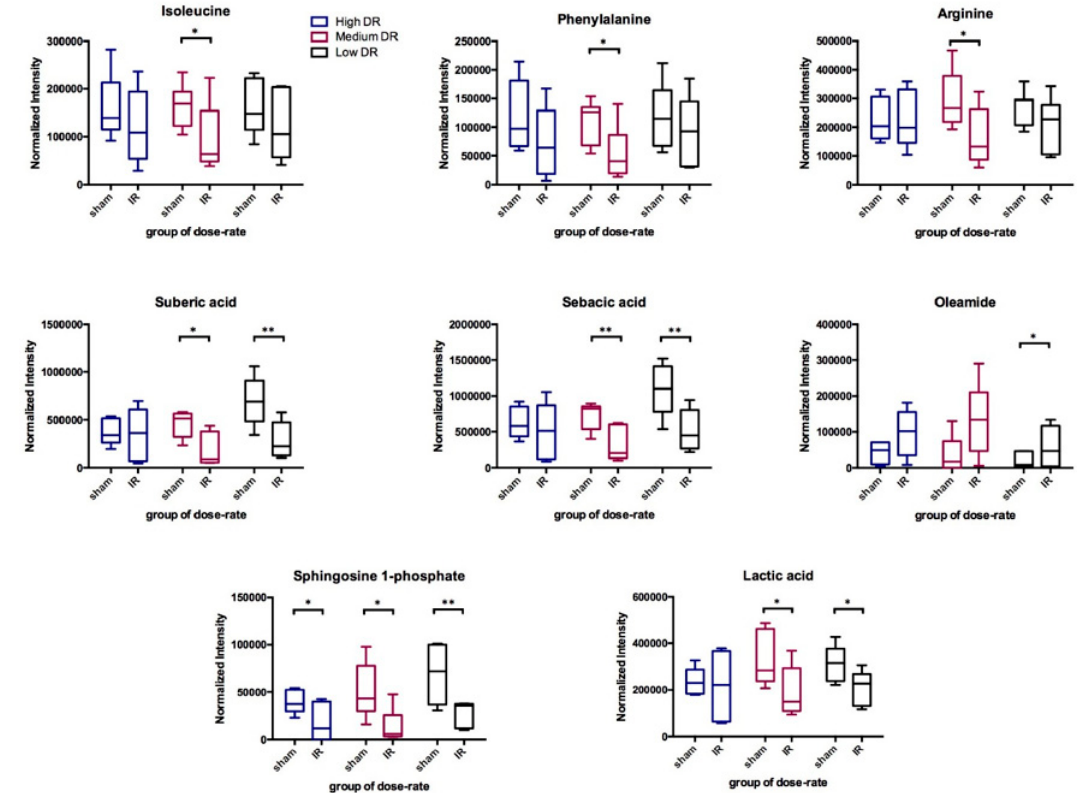
Figure 3. Changes in the serum levels of selected metabolites post 137 Cs exposure. These metabolites were selected based on their statistical significance as determined by Mann-Whitney U test (value < 0.05) and biological importance. The identities of these ions were validated via MS/MS against pure standards and through MS/MS spectra published in METLIN databases. Data at the time points where a cumulative dose of 4 Gy achieved in each dose-rate group are showed.